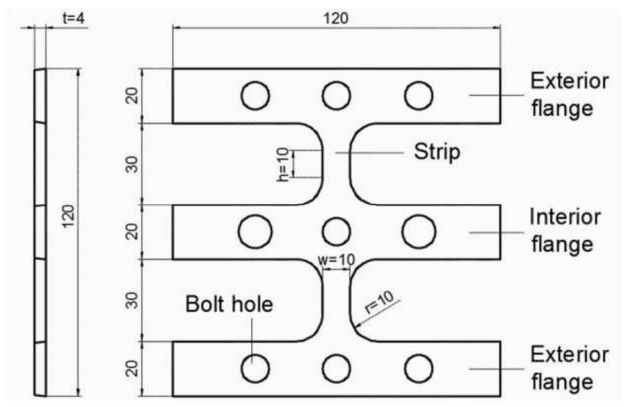
Figure 5. Test specimen (nominal dimensions in mm).